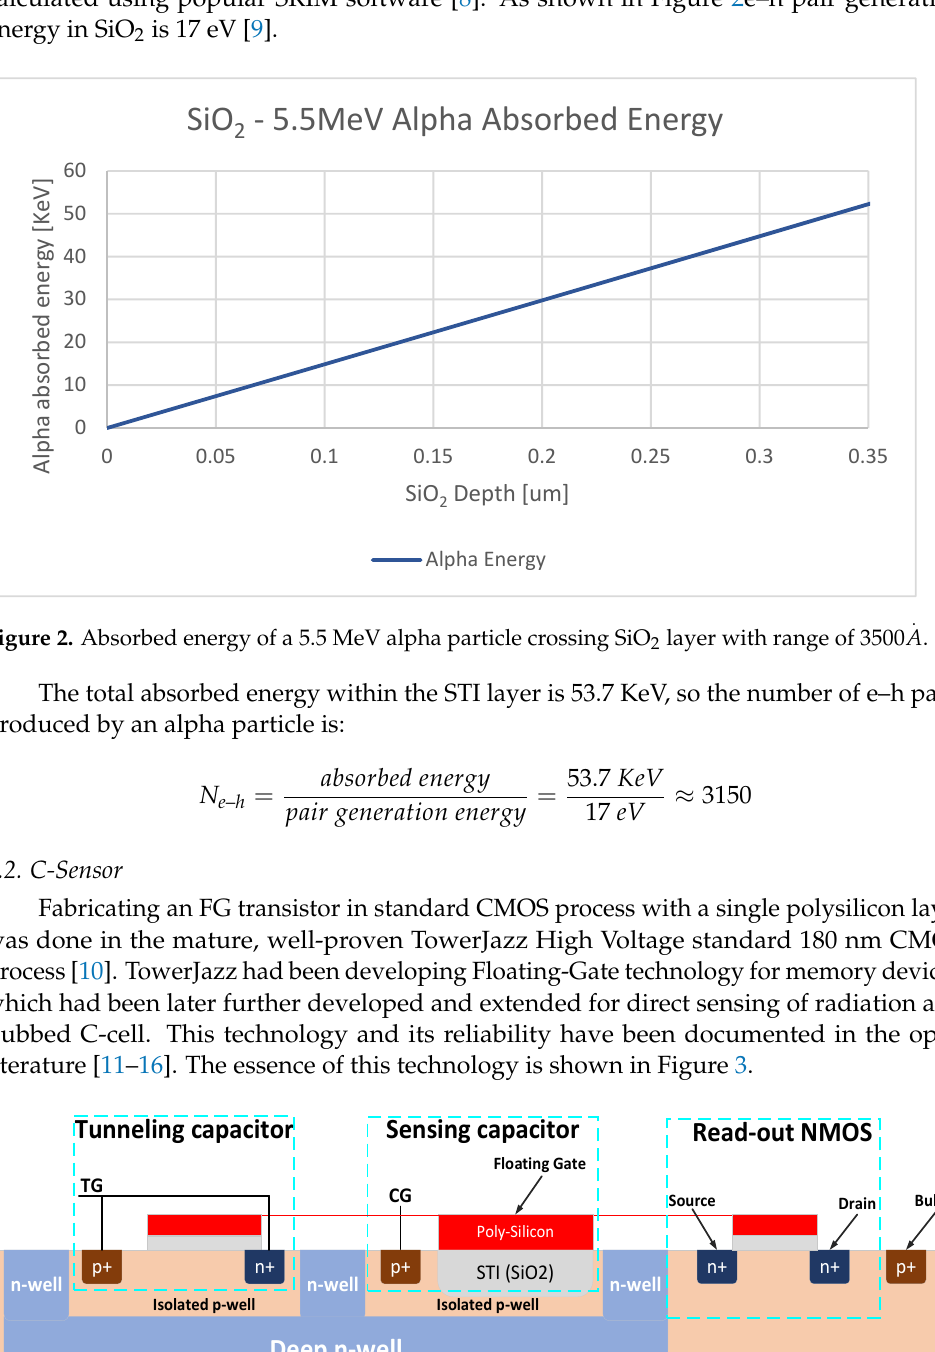
Figure 1. FG transistor radiation response illustration: ( a ) Sensing capacitor charging. ( b ) e–h gen- eration and separation. ( c ) Threshold voltage shift: 𝑪 𝒔𝒕𝒊 —sensing area capacitance; 𝑸 𝒊𝒏𝒋 —injected charge by FN tunneling; 𝑸 𝒊𝒐𝒏 —ionized charge in an alpha incident.